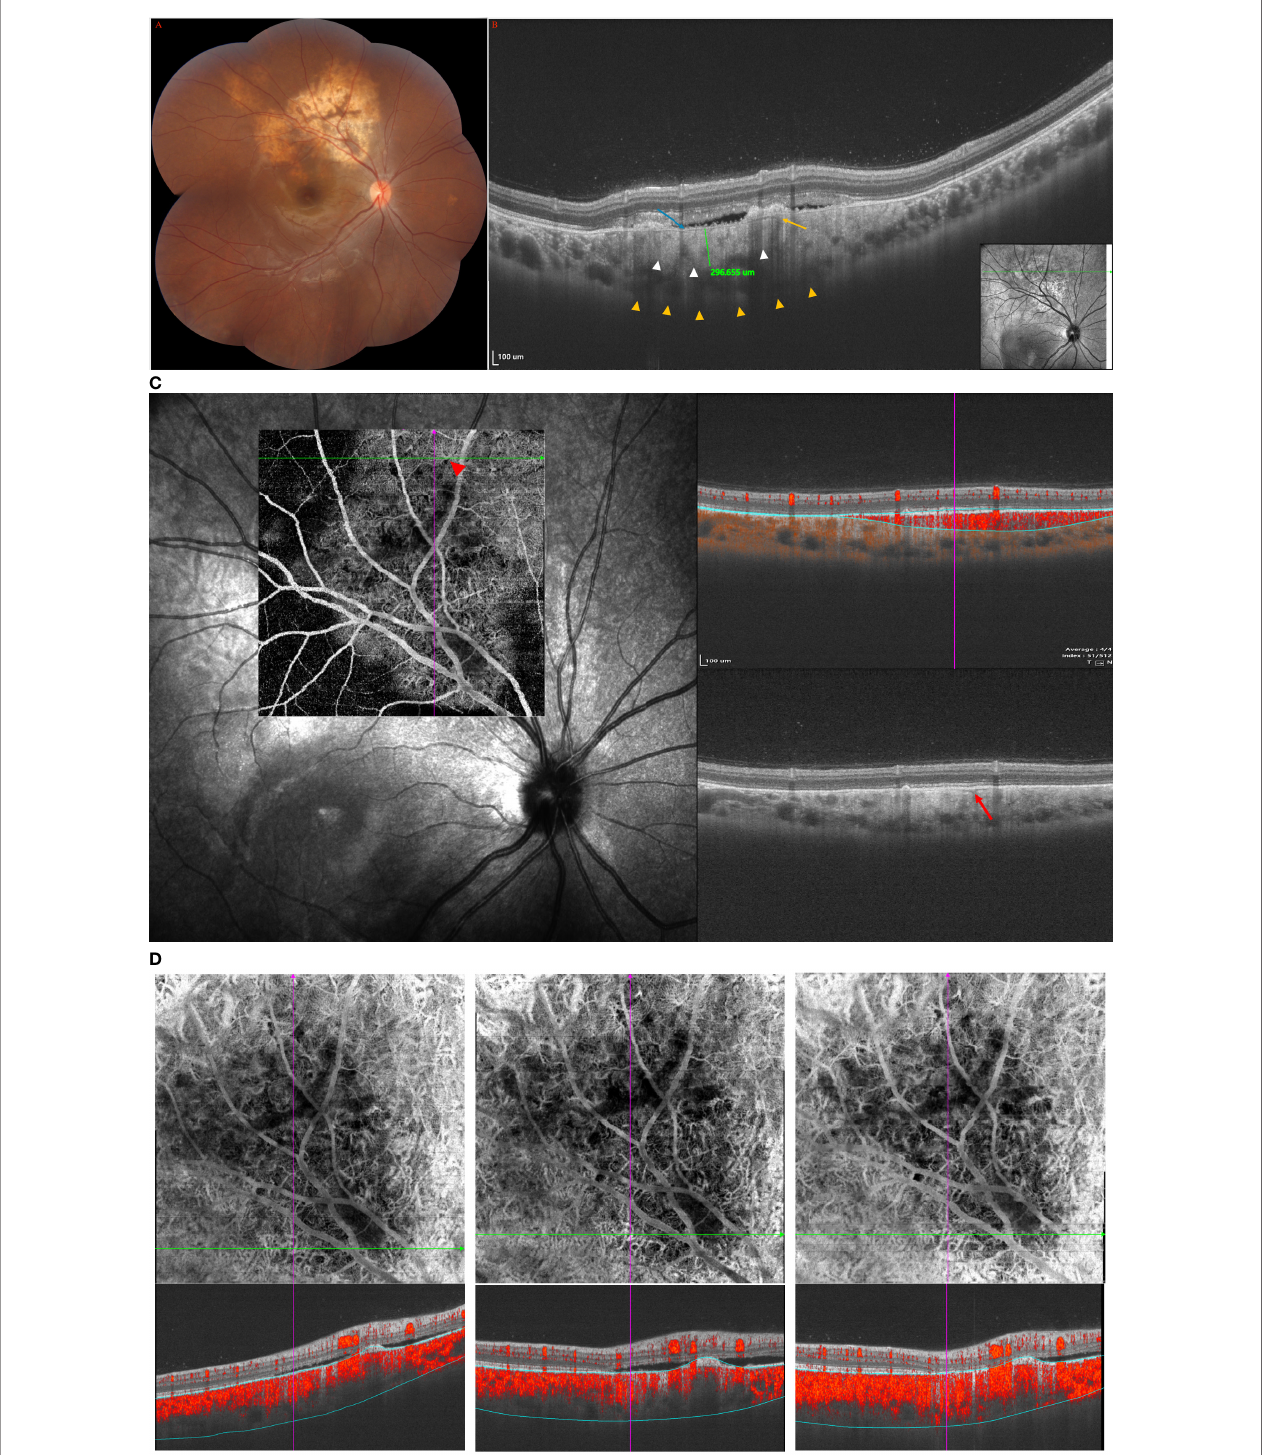
FIGURE 2 | (Patient 2) (A) Fundus examination revealed a yellowish-orange lesion located at peripapillary associated with a local SRF involved macular. (B) On the SS-OCT, B-scan revealed a 296- m m-thick fl at osteoma in the early stage. 16 mm B-Scan: long orange arrows: Haversian or Volkmann vascular channels; blue arrow: alteration of external retinal layers and RPE above the tumor; white arrow: the external choroid seems pushed toward the outside and compressed. The trabecular bone, dense bone, and striated bone were not demonstrated in the early stage of the tumor. (C) The SFVNs and tangled vascular structures of tumor- related vasculature were clearly seen on SS-OCTA before and after anti-VEGF treatment. (D) Two months after the second ranibizumab (0.5 mg) injection, SS-OCTA showed regression of SRF, but no reduction of the terminal vessels in the tumor-related vasculature that appeared as a dilated vessel connected to the